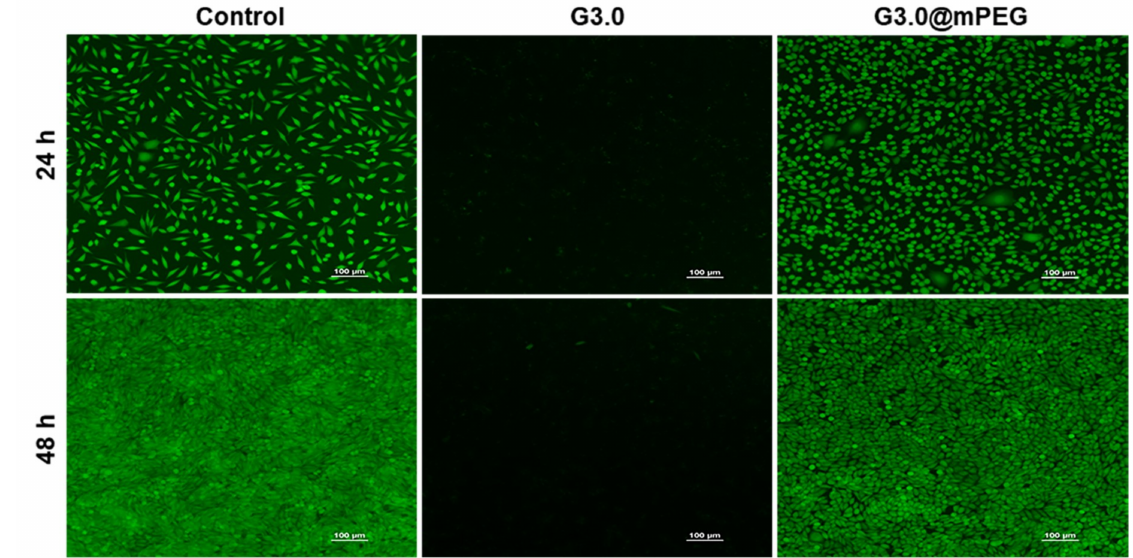
Figure 6. Fluorescent image of live / dead staining of L929 cells after culturing for 24 h and 48 h with media (control), PAMAM G3.0 (500 µ g / mL) and PAMAM G3.0@mPEG (500 µ g / mL). Scale bar = 100 µ